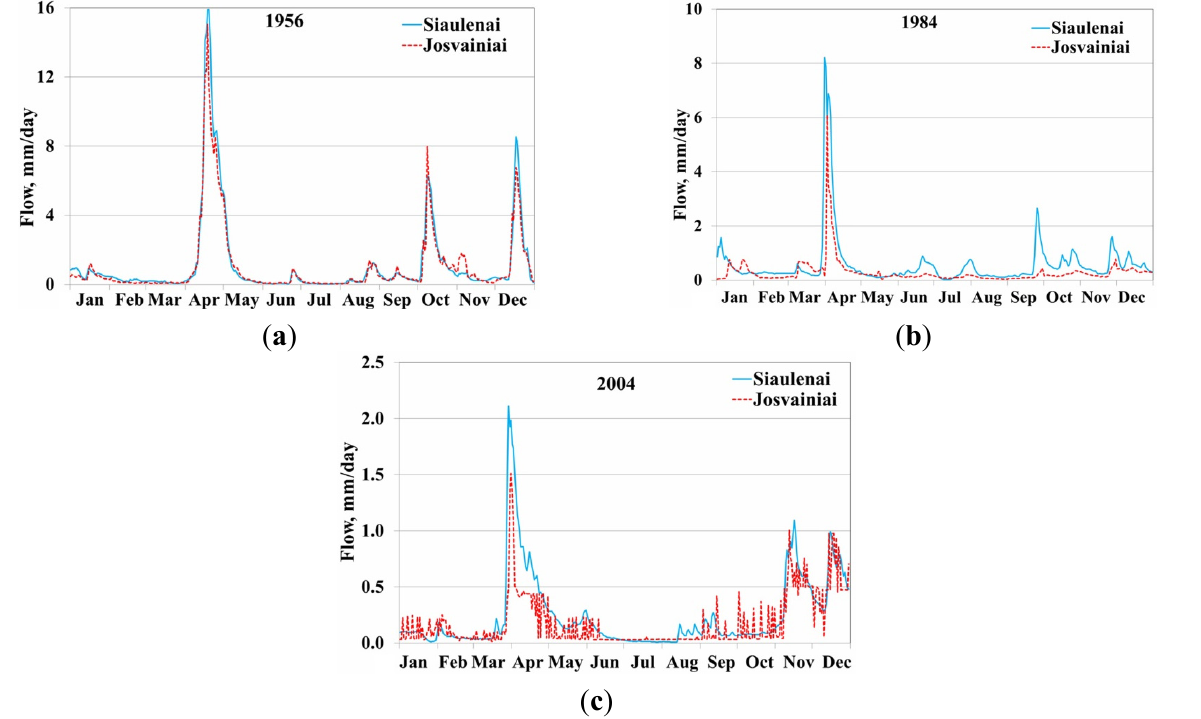
Figure 4. Daily flow of selected years from different periods at Siaulenai (reference station, control river—no impact), and Josvainiai (impact of reservoirs and SHP) gauging stations. ( a ) 1956—pre-impoundment: No reservoirs at either subbasin; ( b ) 1984—post-impoundments: